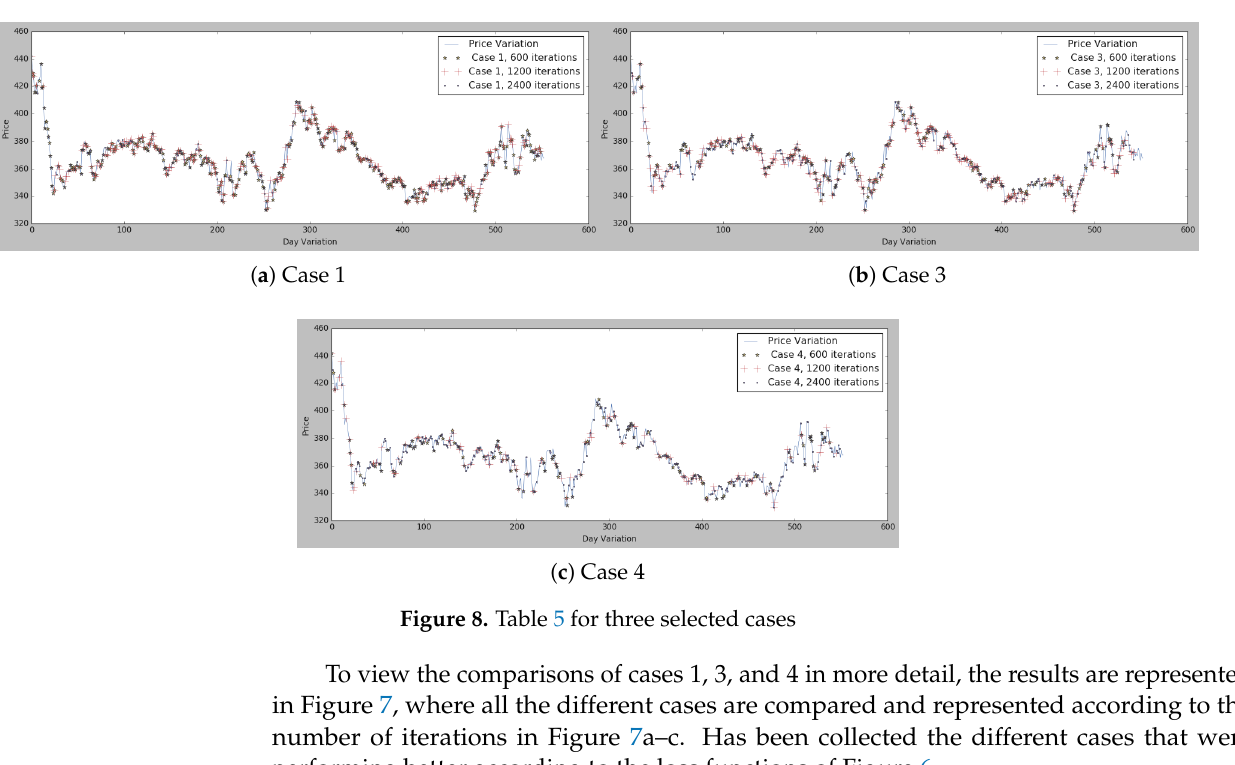
Figure 7. Lowest price identification with different iterations on the basis of the parameters described in Table 5 for each case.